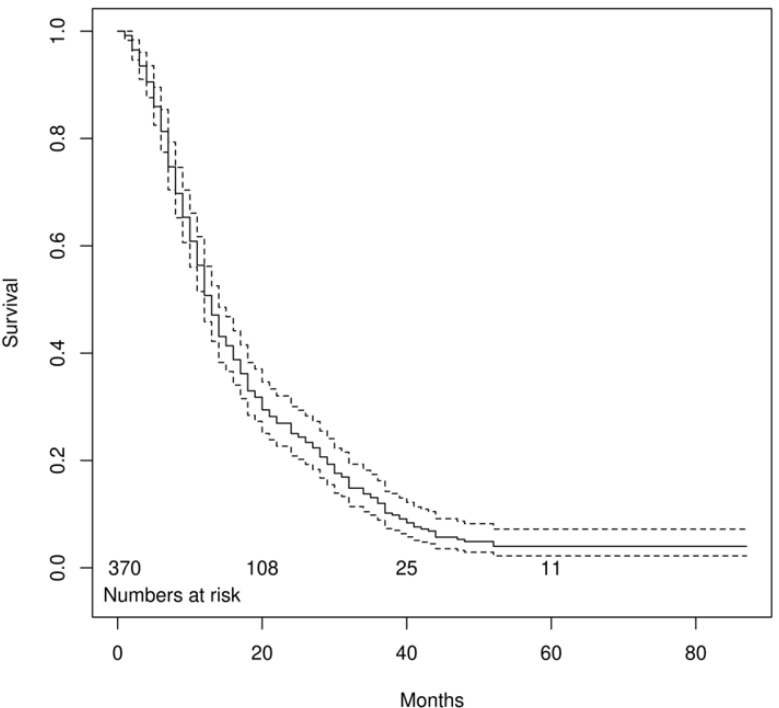
Figure 2. Kaplan-Meier curve showing overall survival in our cohort, with a 95% confidence interval in dashed lines (Median survival 13 months, CI: 12 – 14). in dashed lines (Median survival 13 months, CI: